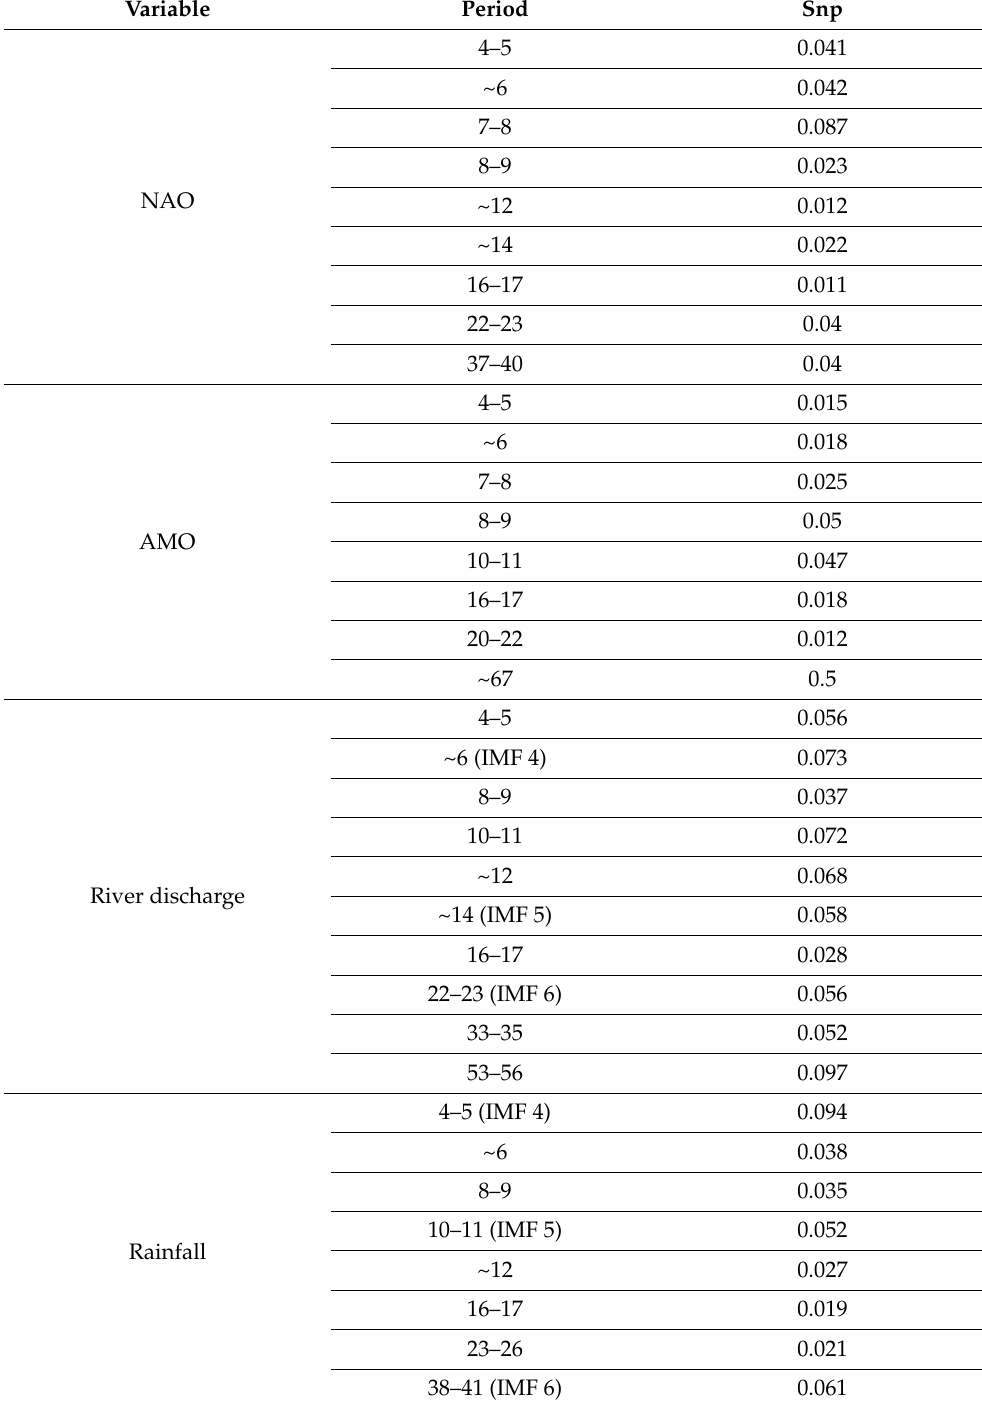
Table 2. Most evident periodicities that affect the variables considered in this study, and their related Standard Normalized Power (Snp, according to Baluev [120]). Indications in parentheses for some periodicities highlight their dominance within a specific